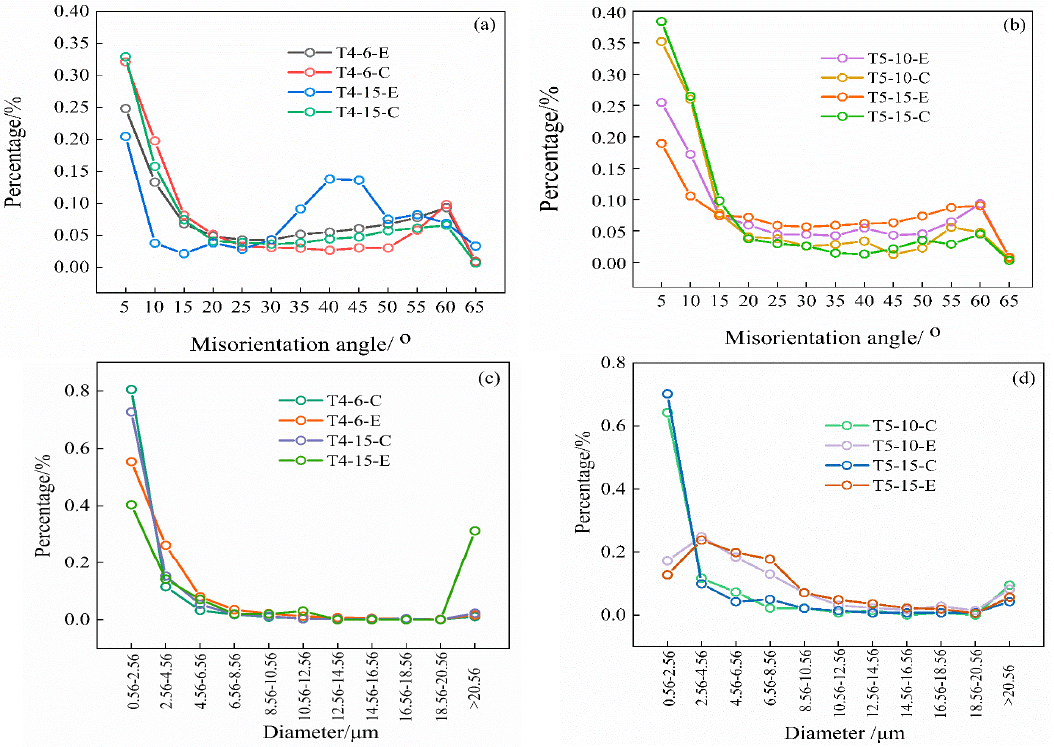
Figure 4. Distribution trend of misorientation and grain size of 7B05 aluminum alloy, where E represents the surface layer of the rolled plate, C represents the center layer of the rolled plate: ( a ) misorientation distribution of T4; ( b ) misorientation distribution of T5; ( c ) diameter distribution of T4; ( d ) diameter distribution of T5.